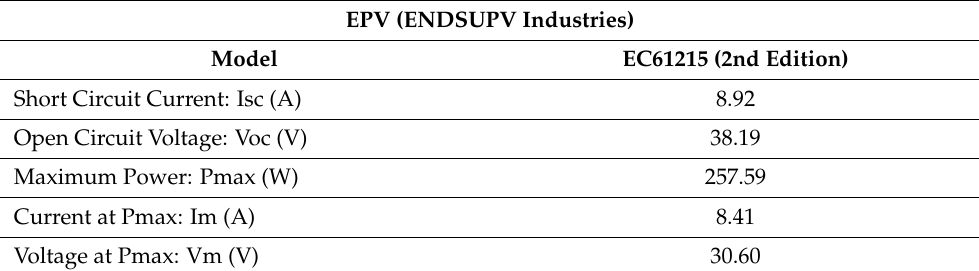
Table 2. Specification of PV